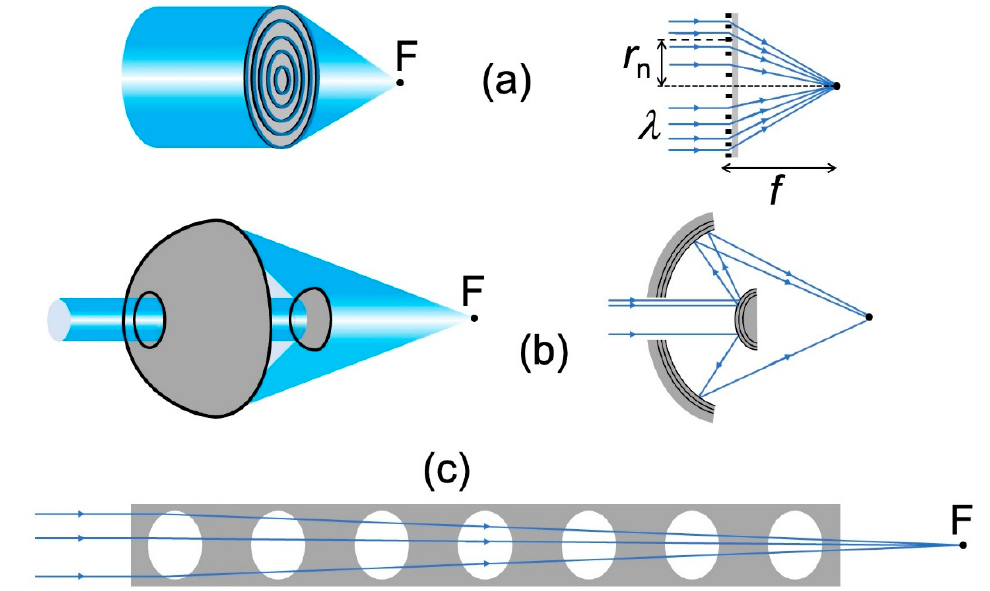
Figure 13. Three types of X-ray lenses: ( a ) Fresnel zone plate [12,14,18–24]; ( b ) Schwarzschild objective [25] with multilayer coatings to enhance the X-ray reflection at the relevant surfaces; ( c ) compound refractive lens [26].